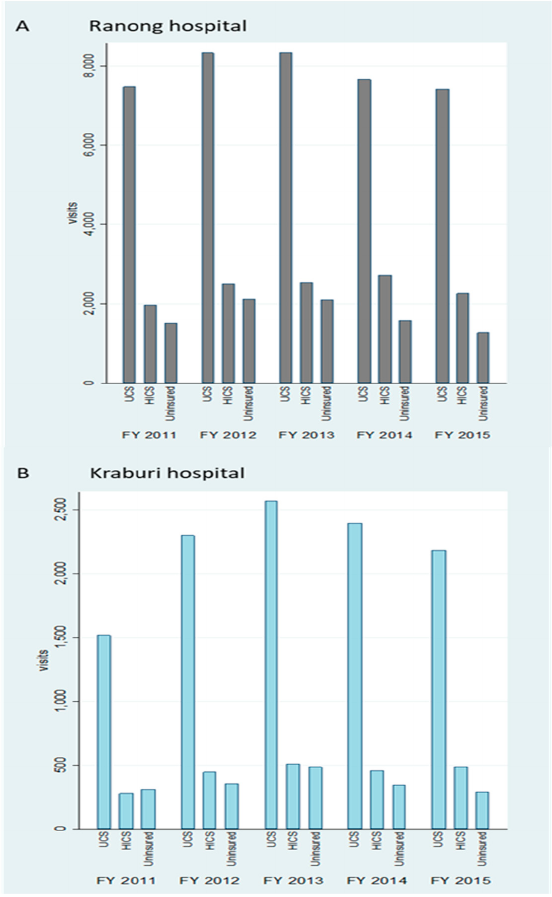
Figure 3. IP utilisation volume in Ranong Hospital ( A ) and Kraburi Hospital ( B ) by the top three most common insurance schemes by